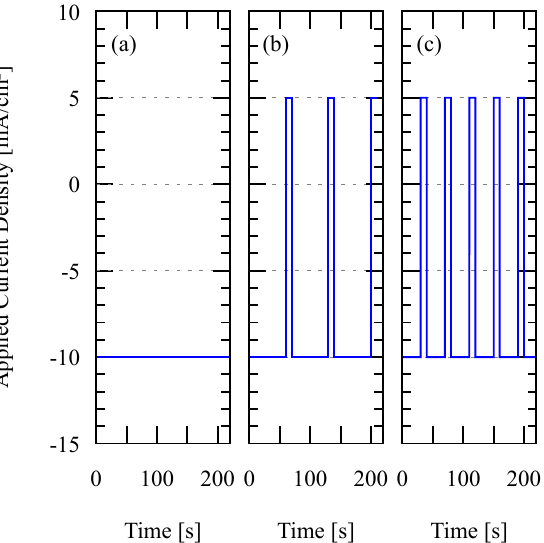
Figure 3. Deposition current density as a function of time in ( a ) pure DC deposition; ( b ) RGP deposition with 60 s forward and 10 s reverse current duration and ( c ) RGP deposition with 30 s forward and 10 s reverse current duration. Negative current density indicates the deposition